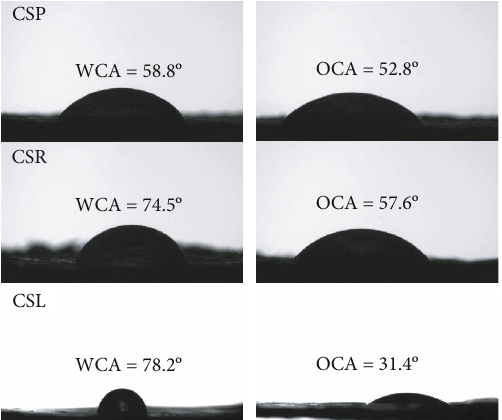
Figure 6: The water and oil contact angles of corn stover pith, rind, and